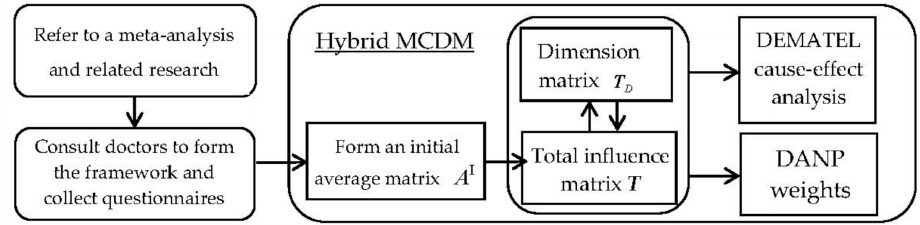
Figure 1. Research flow of the hybrid MCDM (multiple criteria decision-making)